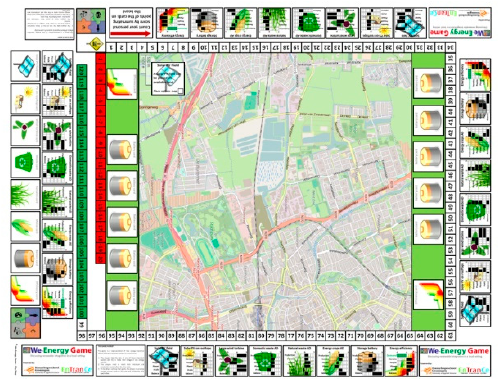
Figure 1. Map of the game.